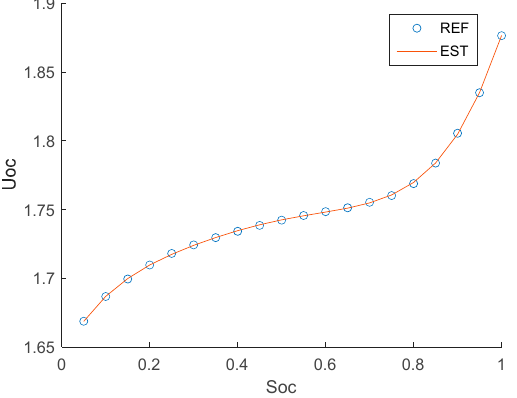
Figure 4. Open circuit voltage fitting curve. The ohmic internal resistance of the battery can be calculated from the data of voltage dip at the moment of power-on or voltage surge at the moment of power-off, corresponding to the voltage between points A and B and C and D. The process B to C represents the zero state response and the DE segment represents the zero input response. The identification process is shown in Figure 5.